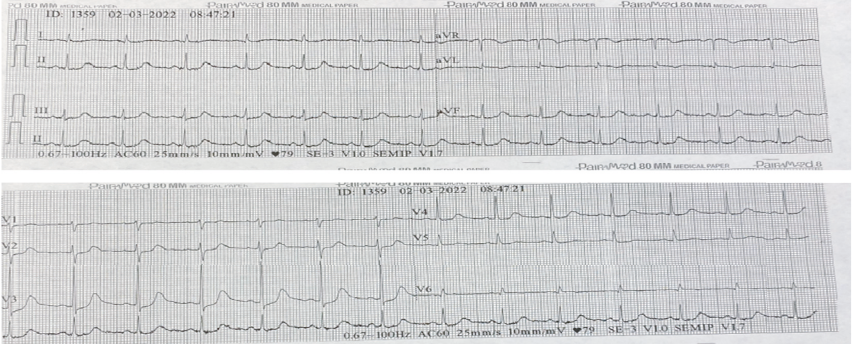
Figure 2: Initial electrocardiogram of the referral site (posterior leads). Sinus rhythm and extension of ischemia to the posterior face of the heart is ruled out.